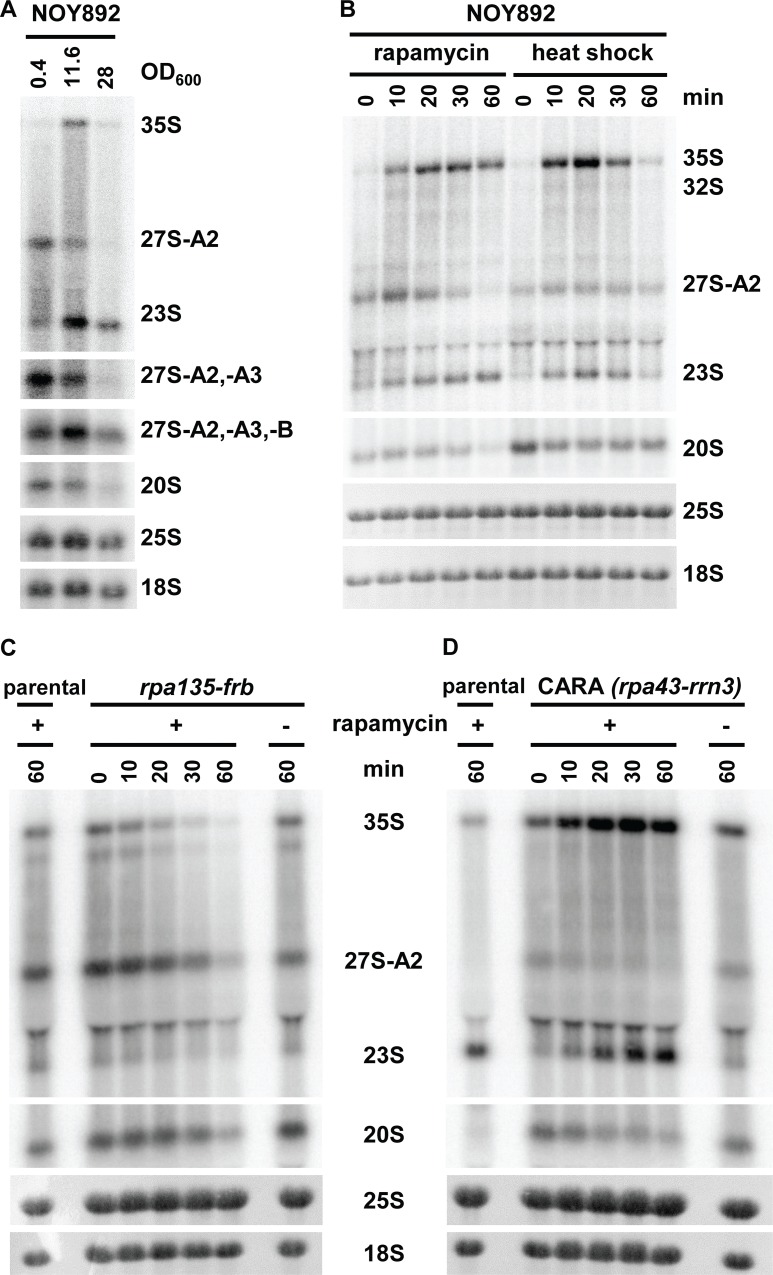
The switch from the A2 to the A3 pathway is not dependent on RNA pol I.(A) Northern blot analysis of the pre-rRNA processing in the strain NOY892, grown in YP-galactose. Hybridization probes as described in Fig 1A and 1B. (B) NOY892 was treated with 200 ng/ml rapamycin at OD600 = 2 or exposed to heat shock by shifting from 25°C to 37°C. (C) Northern blot analysis of pre-rRNA processing in the anchor-away strain BEN135, expressing Rpa135–FRB fusion treated with rapamycin at OD600 = 2. (D) Northern blot analysis of the pre-rRNA processing in the CARA strain treated with rapamycin OD600 = 2.